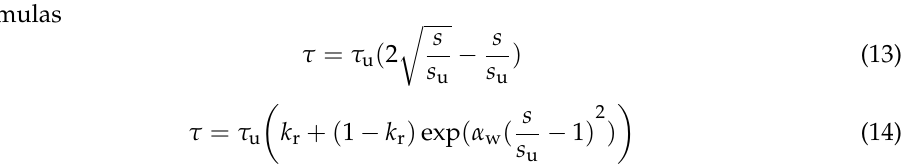
Figure 12. Bond stress-slip curve of Model 3. The shape coefficient α w can be obtained by the fitness of test curves. As presented in Figure 13, the values of shape coefficient α w decreases with the increase of fiber factor and can be expressed as a linear regression formula. However, the correlation of α w and λ f is very low, due to the large variation of the descending portion of curves. This indicates